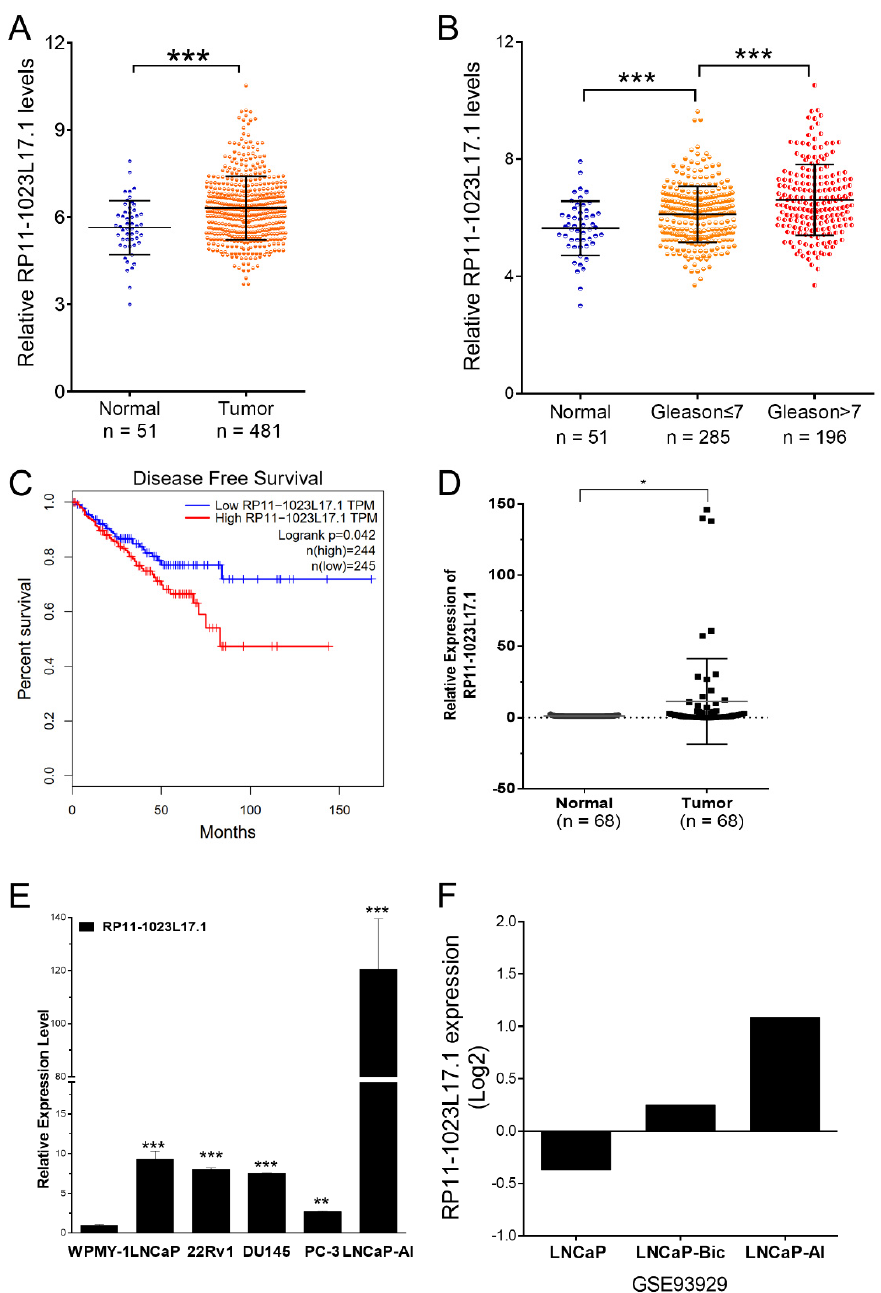
Figure 2. RP11-1023L17.1 is highly expressed in PCa. ( A ) Analysis of the expression levels of RP11-1023L17.1 in PCa tissues and normal tissues acquired from the TCGA database. ( B ) Analysis of the relationship between the expression of RP11-1023L17.1 and the pathological grade of PCa. ( C ) Kaplan–Meier curves for disease-free survival of PCa patients in a published dataset acquired from TCGA, using the high quartile RP11-1023L17.1 level as the cutoff. ( D ) The expression levels of RP11-1023L17.1 in 68 paired PCa tissue samples measured by RT-qPCR. ( E ) The relative expressions of RP11-1023L17.1 in normal prostate stromal cell line WPMY-1 and PCa cell lines LNCaP, 22Rv1, DU145, PC-3, and LNCaP-AI were measured by RT-qPCR. The data were normalized against WPMY-1, and β -Actin were used as housekeeping references. ( F ) The GEO dataset GSE93929 analysis showed the expression of RP11-1023L17.1 in androgen dependent (androgen sensitive) cell line LNCaP and androgen independent (castration resistant) cell lines LNCaP-Bic and LNCaP-AI. Data are presented as mean ± SD ( n ≥ 3). * p < 0.05, ** p < 0.001, and *** p <